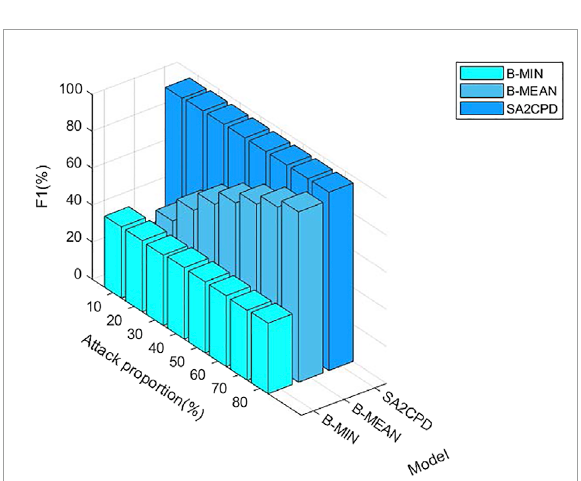
FIGURE 7 The F1 score of our SA2CPD model, the B-MIN model and the B-MEAN model under different attack